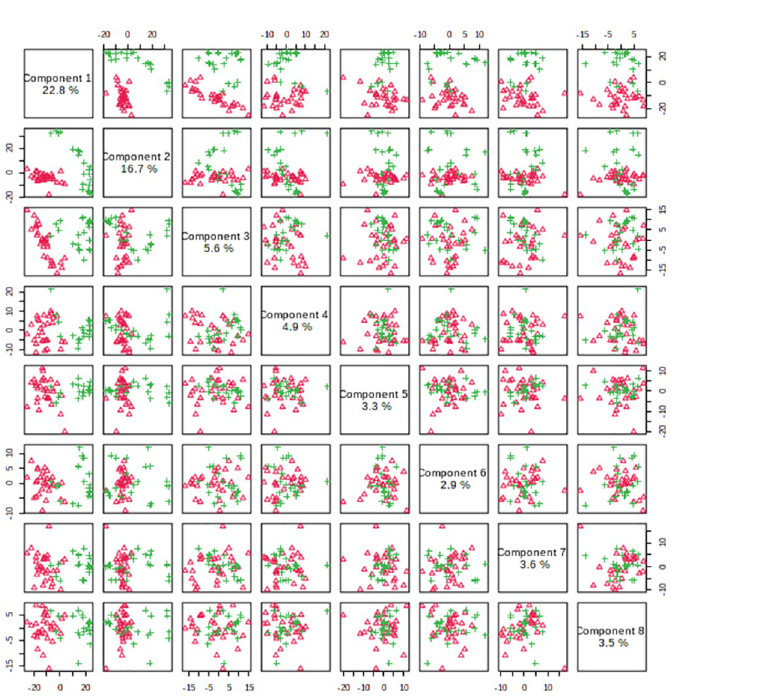
Fig 4. Pairwise scores plots between the selected